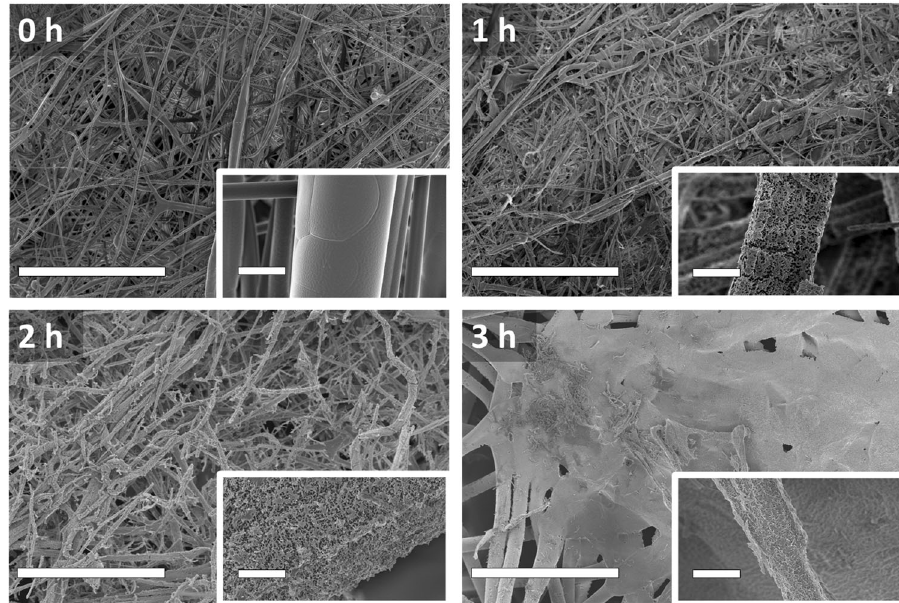
Fig. 4 SEM images of the middle ( fi lter) layer of a mask. SEM images of fi bres in a face mask record at the noted magni fi cations after plasma treatment for 0 – 4 h of the middle ( fi lter) layer. Scale bar = 200 μ m (6 μ m in